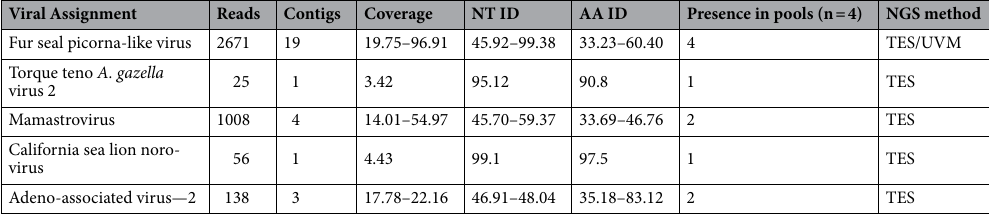
Table 1. Vertebrate viral assignations obtained from fecal samples sequencing from male A. gazella . Ranges of Genome coverage, nucleotide identity and aminoacidic identity are expressed in percentages.